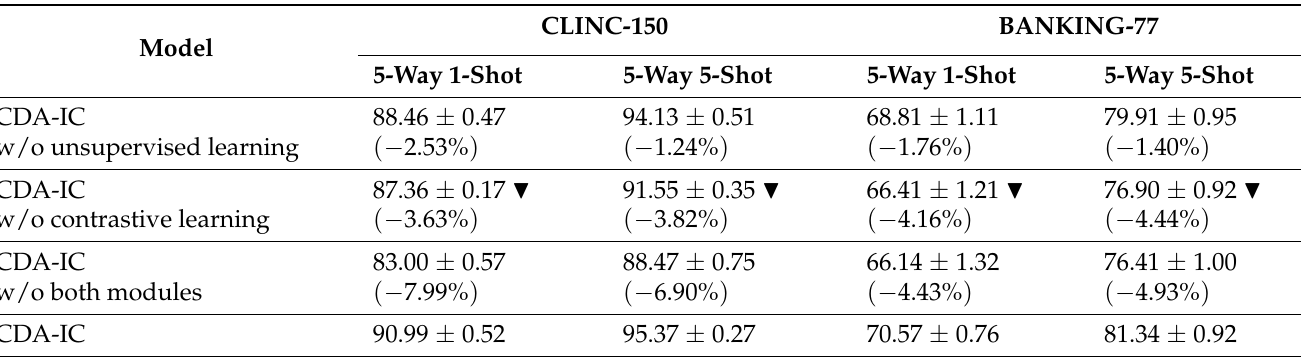
Table 3. Ablation studies of CDA-IC for the 5-way 1-shot and 5-way 5-shot meta tasks on CLINC-150 and BANKING-77. The biggest drop of an independent module in each column is appended (cid:72) .